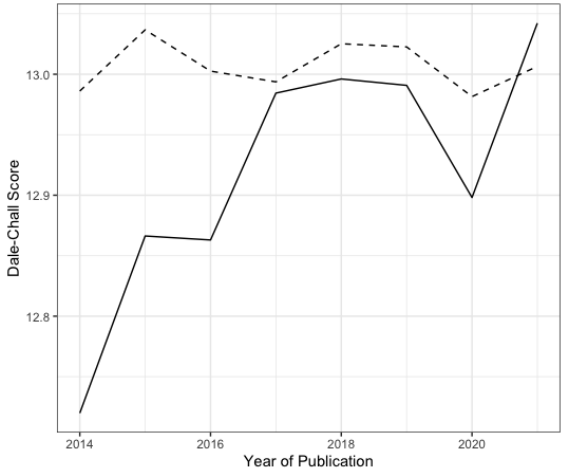
Figure 12. Dale–Chall readability scores for abstracts (dashed line) and introductions (solid line) between 2014 and 2021.